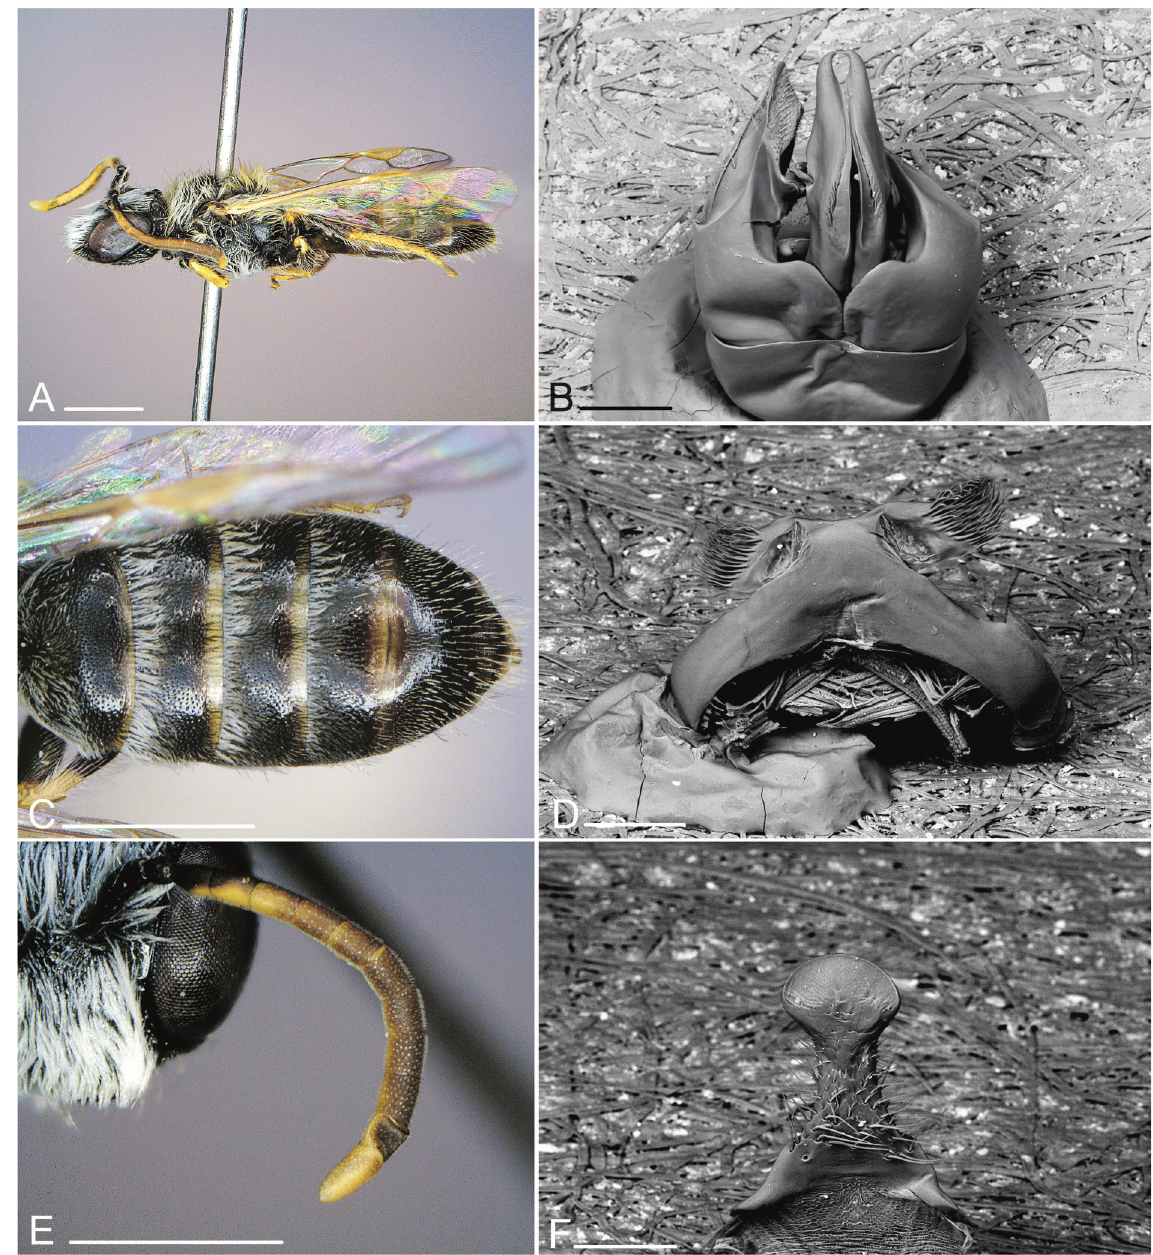
Fig. 24. Scrapter punctatus sp. nov., ♂. A . Lateral view. B . Genitalia (dorsal view, SEM). C . Metasoma (dorsal view). D . S7 (dorsal view, SEM). E . Antenna. F . S8, apical end (SEM). Scale bars: photos: 1 mm, SEM: 0.1